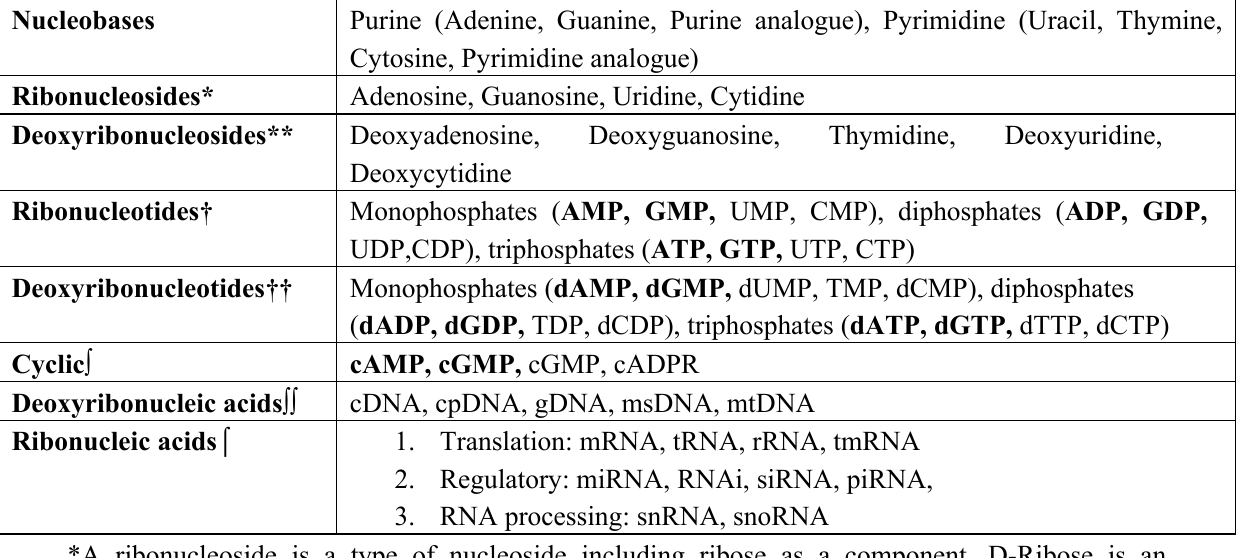
Table 1. Nucleobases, nucleosides, nucleotides and nucleic